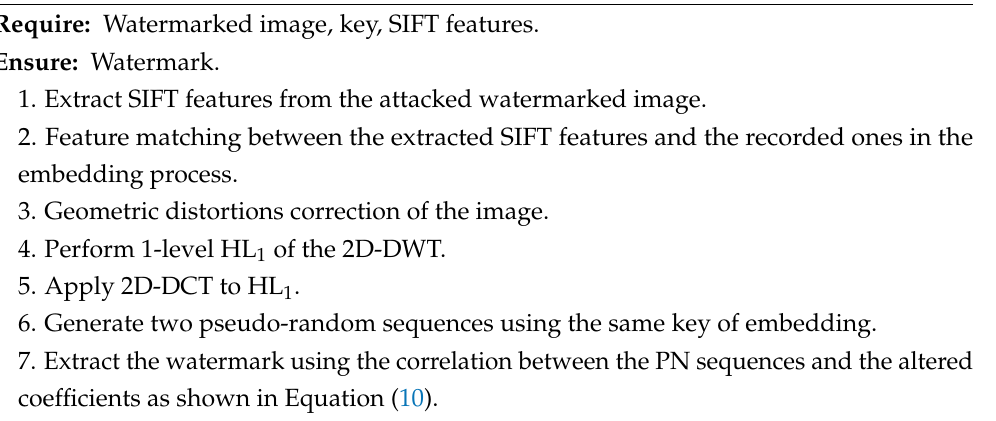
Figure 5. The proposed extracting scheme. Algorithm 2 Watermark